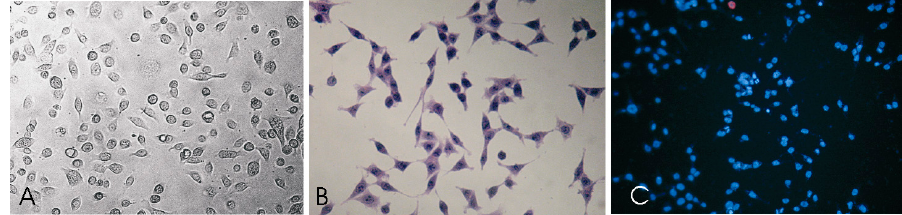
Figure 9. SCC-25 squamous cell carcinoma cell morphology and spreading pattern: nuclear enlargement, highly irregular shaped cells, dense chromatin, prominent nucleoli, cells are connected to each other through short and slender extensions ( A ) nonstained culture, untreated SCC-25 cells, optical